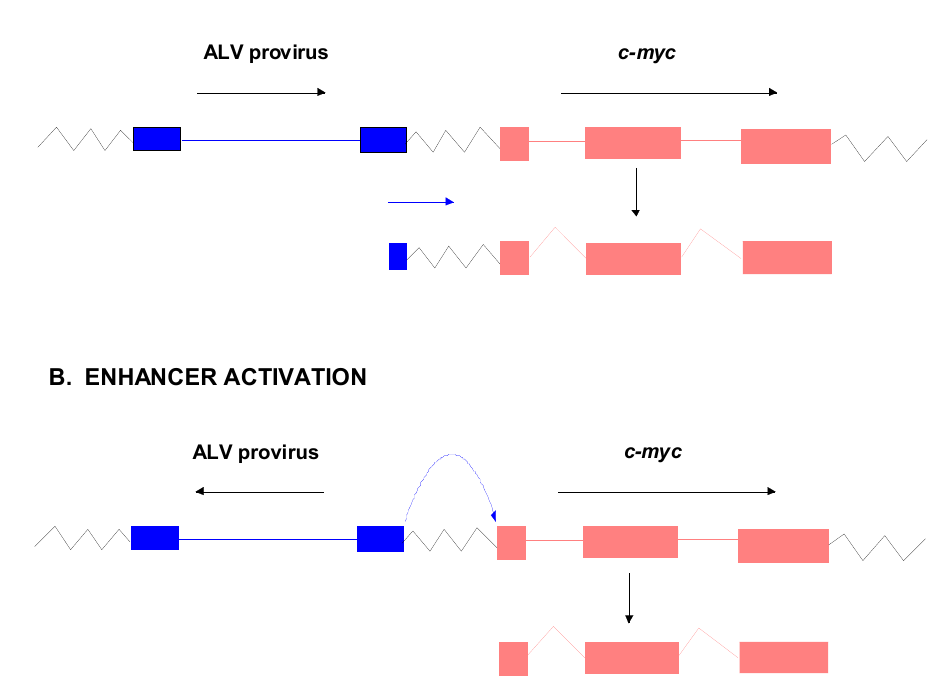
3. Insertion activation of c-myc in avian leukosis virus (ALV)-induced B-lymphomas. ( A ) Promoter insertion activation of c-myc as reported by Hayward et al. [42]. ( B ) Enhancer activation of c-myc (one of the configurations) reported by Payne et al. [43].